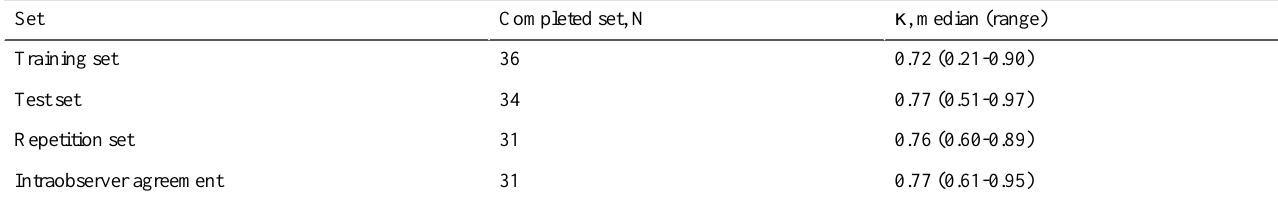
Table 1. Distribution of κ scores per set.